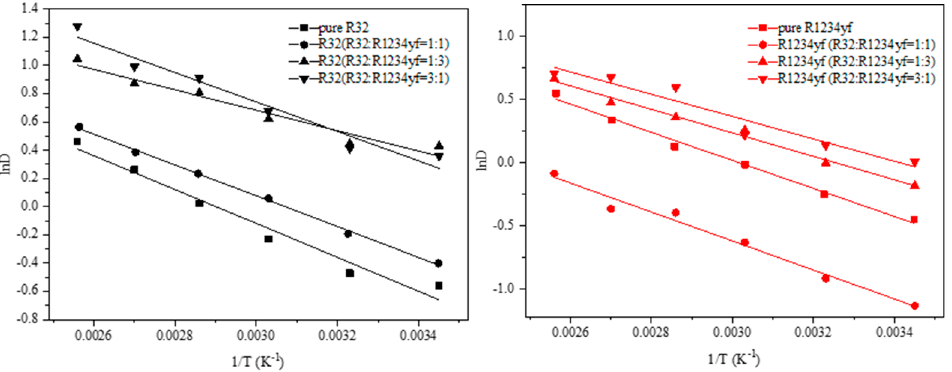
Figure 6. Fitting curves of activation energy of lnD and T − 1.